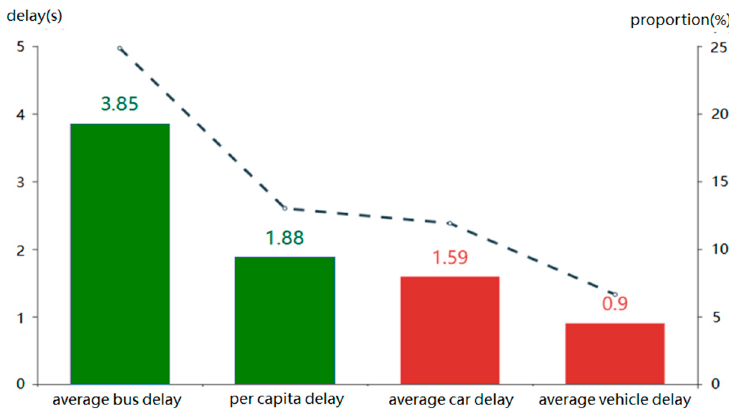
Figure 12. Comparison of the variations in each delay.